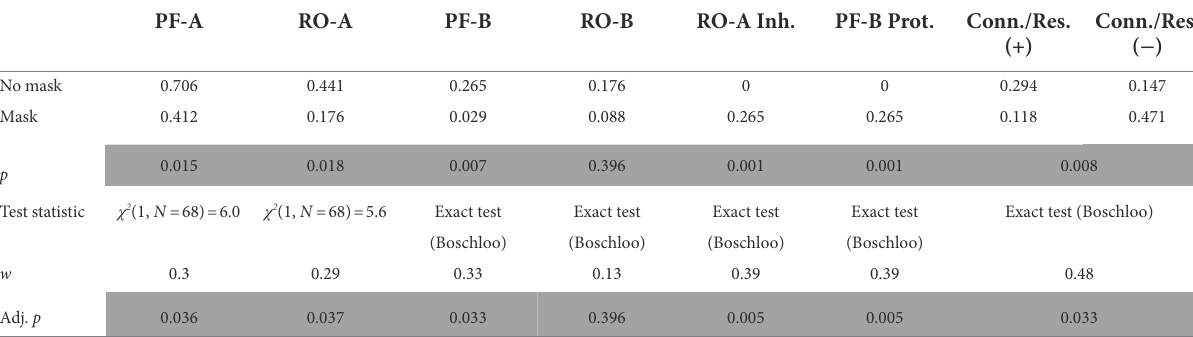
TABLE 3 Level 3: Differences across conditions for portions of data sets with code (binarized).